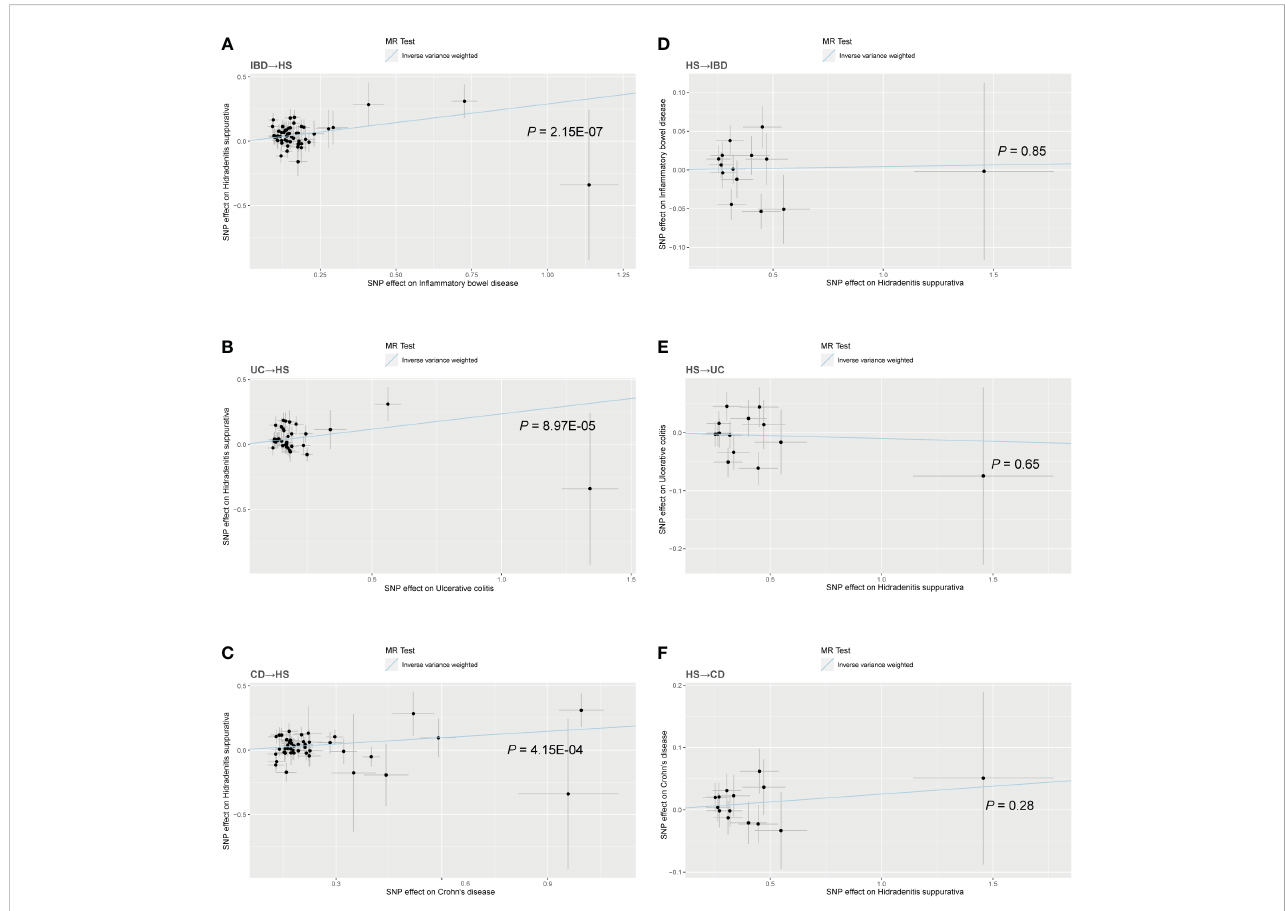
FIGURE 2 Scatter plot of the MR analysis. The slope of each line corresponds to the MR effect estimated by the IVW model. (A) IBD on HS; (B) UC on HS; (C) CD on HS; (D) HS on IBD; (E) HS on UC; (F) HS on